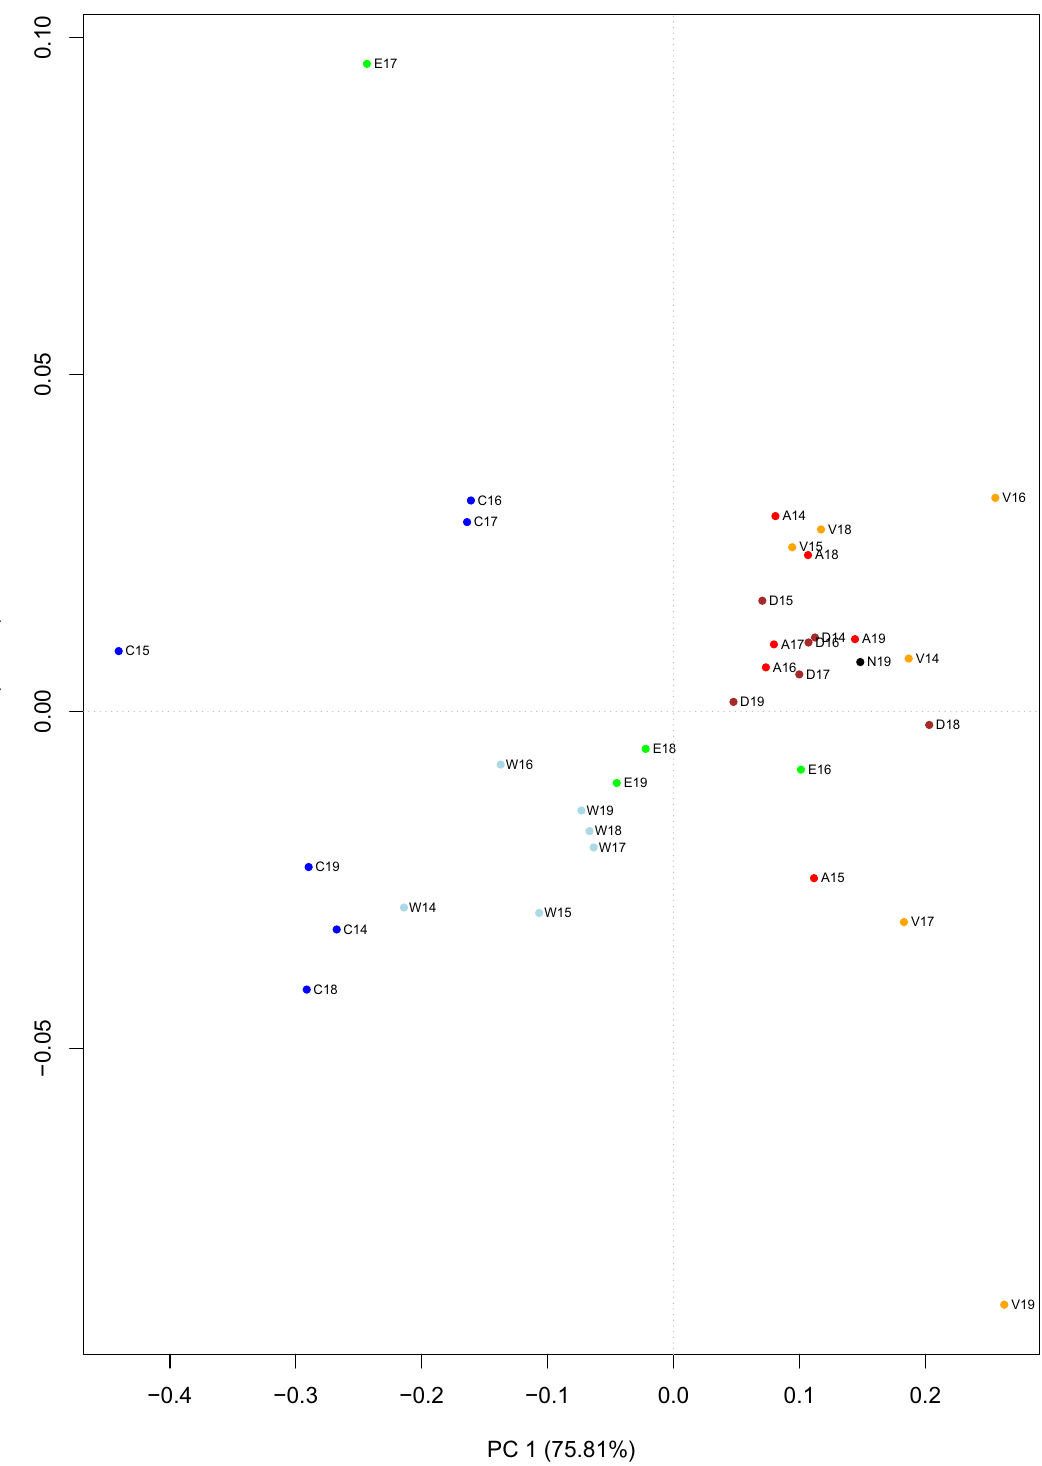
Figure 4. PCoA analysis using the genetic distances between all population pairs. The first and second axes explain 75.81 and 2.28% of the variability, respectively. Three main groups of population can be distinguished: Gulf of Cadiz, Alboran Sea and the remaining populations. Each population is indicated by an initial and a different colour and followed by the year (CADI: C, dark blue; WALB: W, light blue; EALB: E, light green; ALAC: A red; VALE: V, light brown; DELT: D, dark brown; NCAT: N,